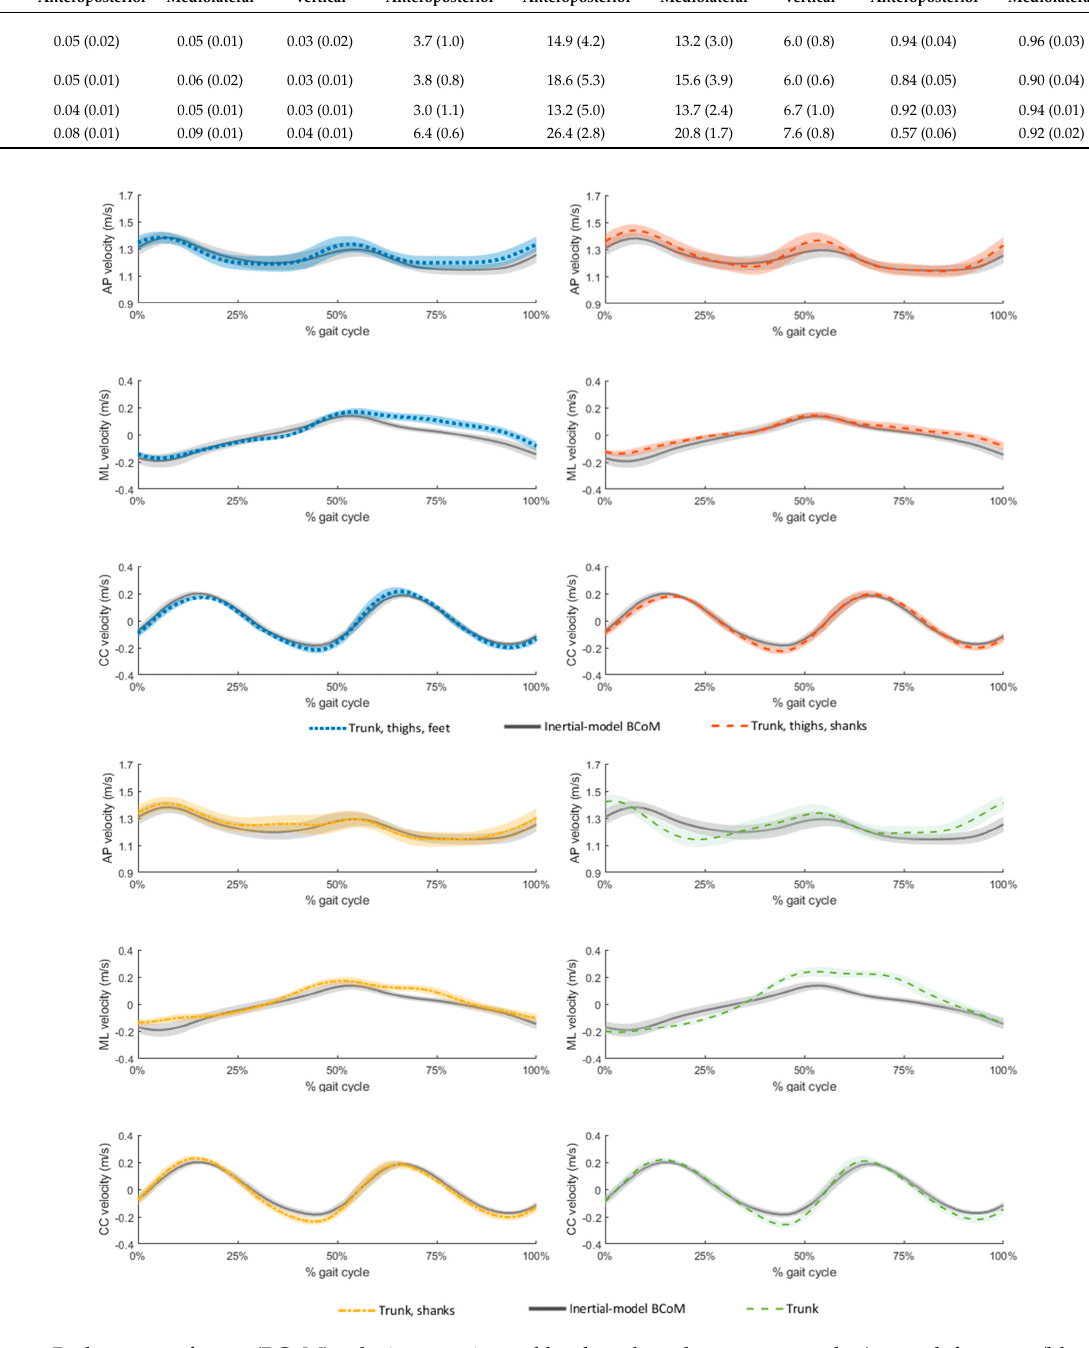
Figure 5. Body center of mass (BCoM) velocity as estimated by the selected sensor networks (upper-left corner (blue dotted lines): trunk, thighs, feet; upper-right corner (orange dashed lines): trunk, thighs, shanks; lower-left corner (yellow dashed lines): trunk and shanks; lower-right corner (green dashed lines): trunk) in comparison with the reference BCoM velocity obtained by optical motion capture (gray straight line). Shaded regions represent the interval [mean − standard deviation, mean + standard deviation] for each estimate of the BCoM velocity averaged over the thirteen prosthetic gait cycles of the participant in the anteroposterior (AP), mediolateral (ML) and vertical (CC) directions.